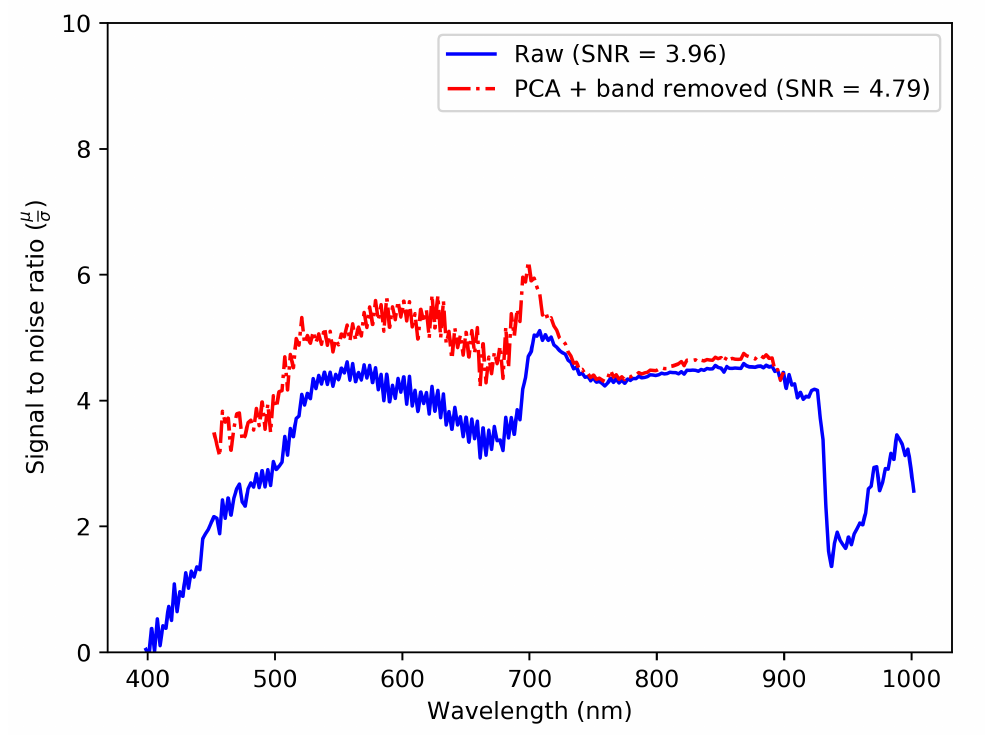
Figure 7. A comparison of signal-to-noise (SNR) across wavelengths before and after spectral denoising. Note the increase in the average estimated